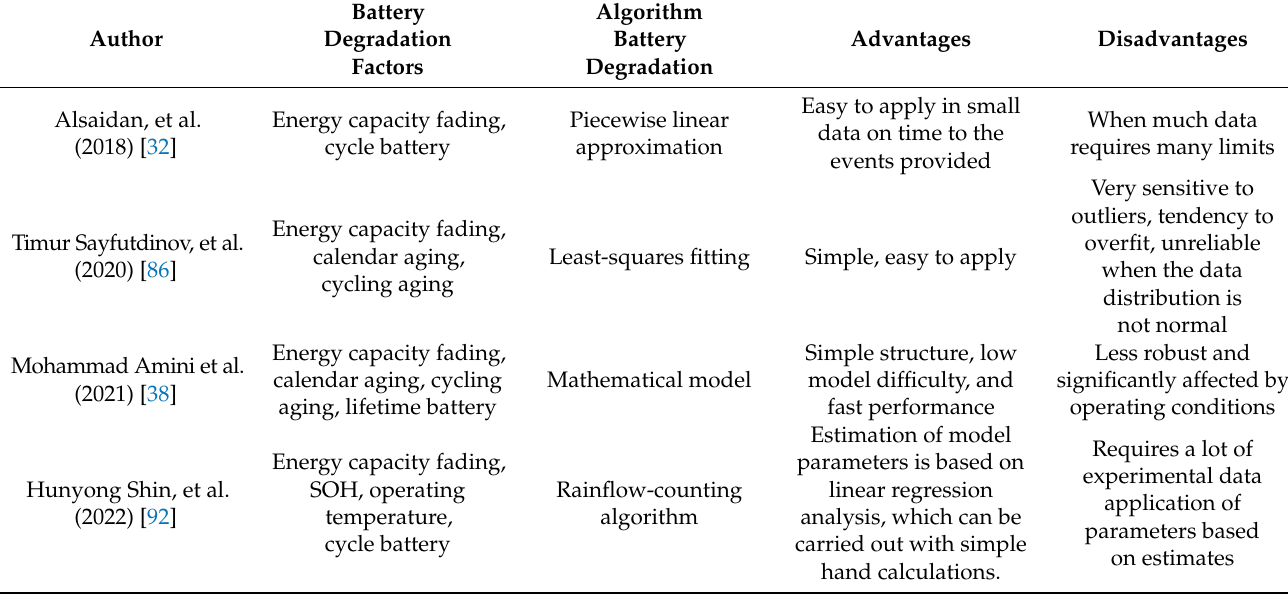
Table 10. Advantages and disadvantages of battery degradation algorithm for BESS